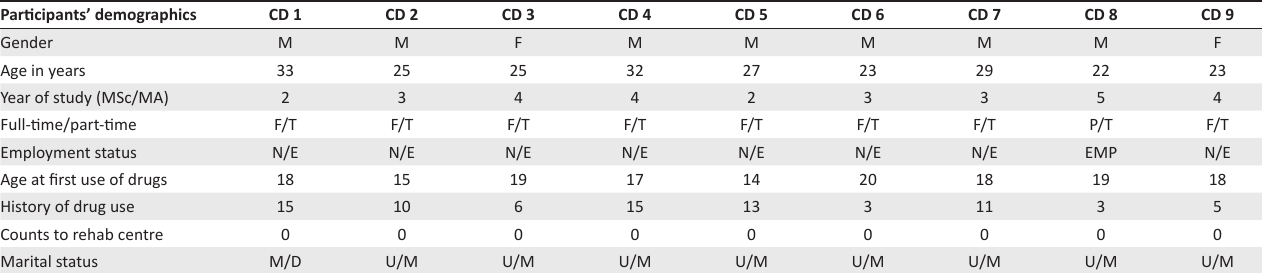
TABLE 1: Presentation of participants’ demographic